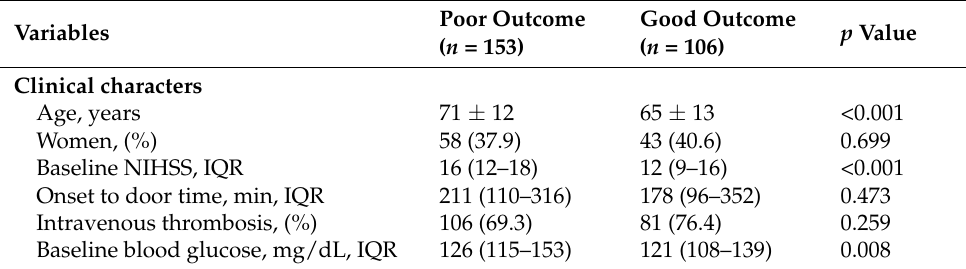
Table 1. Comparison between poor outcome and good outcome